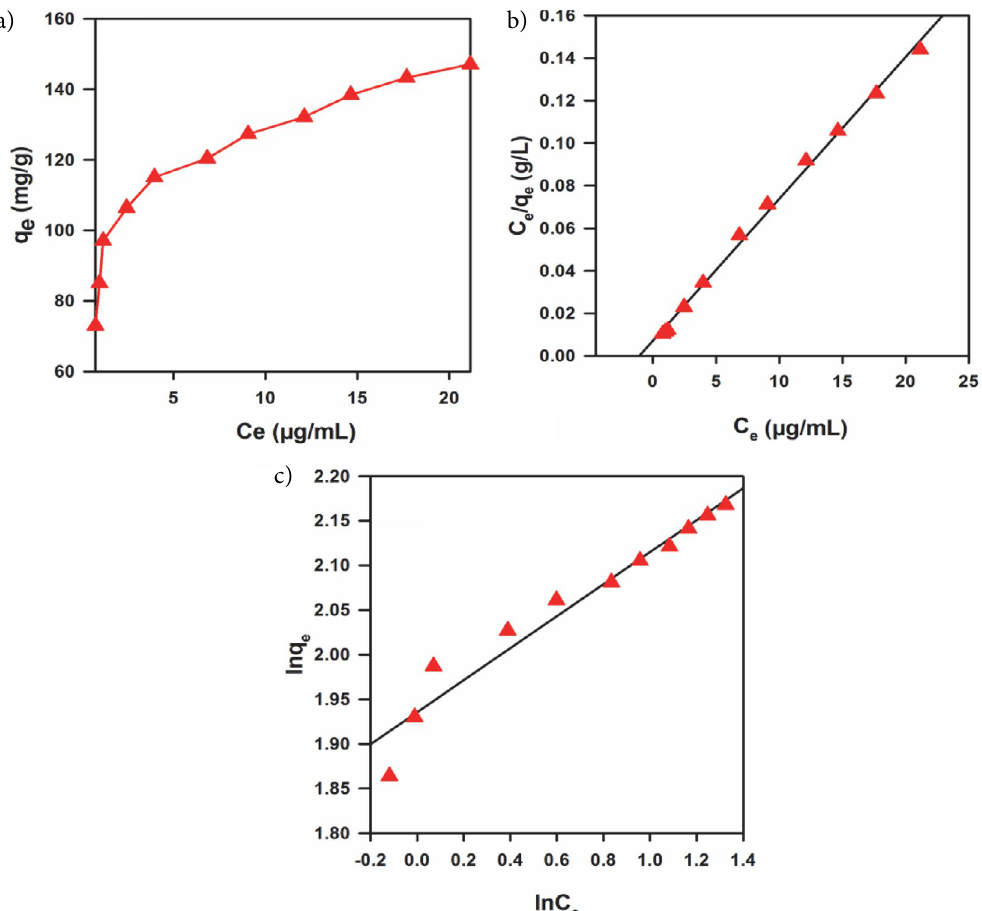
Figure 7. Adsorption isotherm of Erythrosine dye from aqueous solution obtained from (a) experimental evaluation, (b) Langmuir isotherm mod- el and (c) Freundlich isotherm